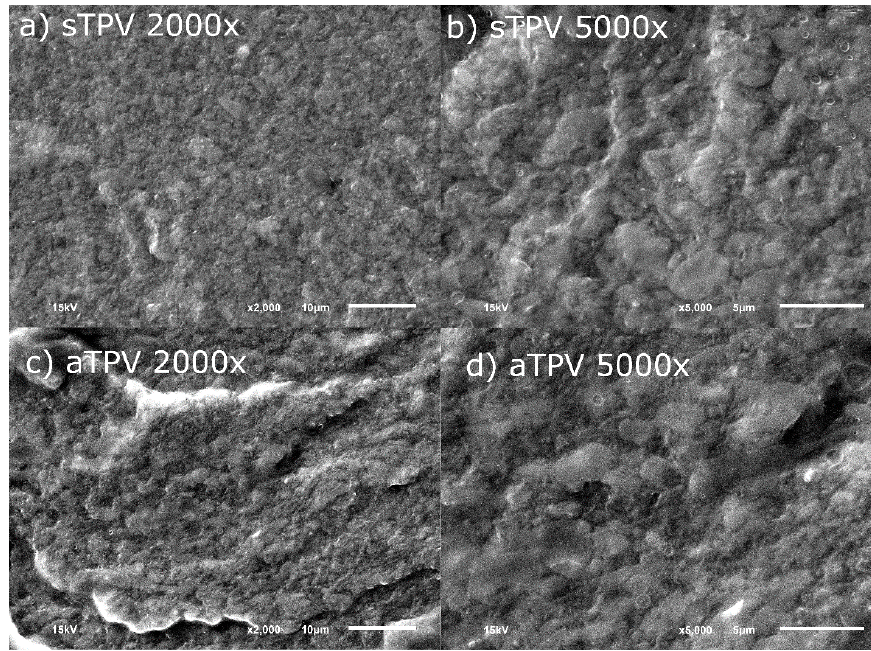
Figure 2. Fractured surfaces of ethylene vinyl acetate copolymer (EVA)/natural rubber (NR) TPVs with magnification of 2,000 and 5,000 ( a ) sTPV 2000 × , ( b ) sTPV, 5000 × , ( c ) aTPV 2000 × and ( d ) aTPV 5000 × Table 1. Gel content (%gel) and swelling ratio of gel (%swell) of EVA/NR TPVs. uEVA: uncured